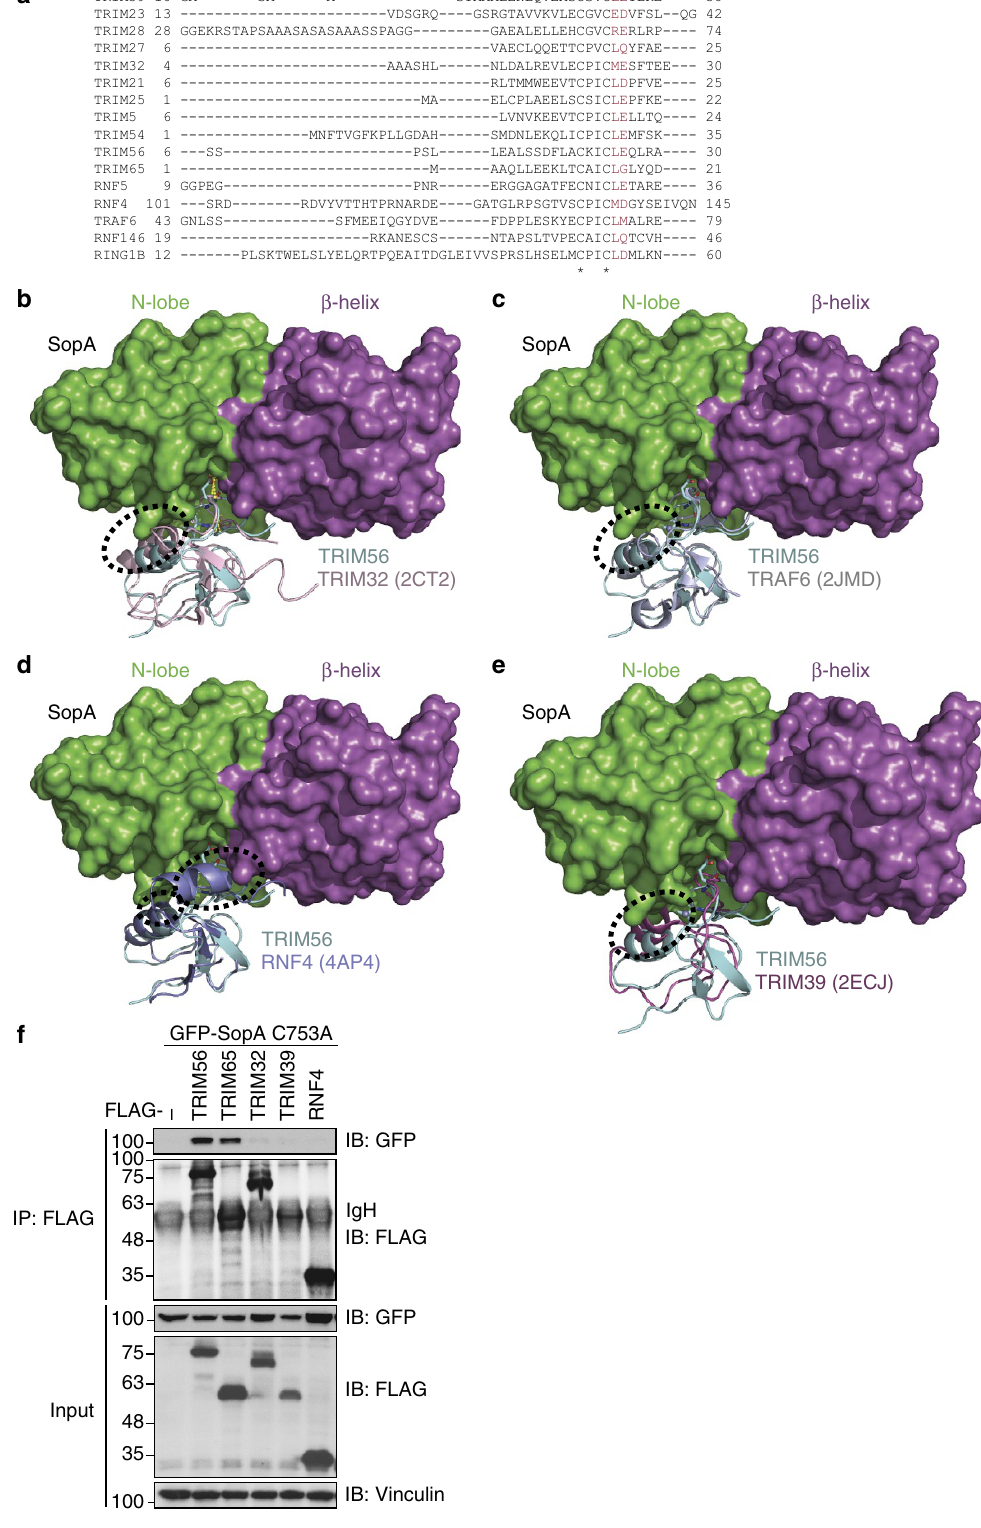
Figure 4 | Structural features of TRIMs define specificity of SopA towards TRIM56. ( a ) Multiple sequence alignment of the first Zn 2 þ -binding loop region from various TRIMs and the closely related RING domain-containing proteins reveal Glu25 and Leu26 (residues in TRIM56 that are involved in binding to SopA) are fairly conserved (coloured in red). Zn 2 þ -coordinating cysteines are indicated using an asterisk. ( b , c , d , e ) TRIM56 RING domain was aligned with various closely related RINGs showing the clashes (circled) of SopA with the central a -helix of various RING domains ( b , TRIM32; c , TRAF6; d , RNF4; e , TRIM39). PDB codes of the structures used in the alignment are indicated in brackets: (2JMD) 47 , (4AP4) 30 . ( f ) SopA does not bind TRIM32, TRIM39 and RNF4. Lysates from cells co-expressing GFP-SopA C753A and indicated FLAG-RING E3 ligase constructs were subjected to anti-FLAG IP, followed by SDS–PAGE and